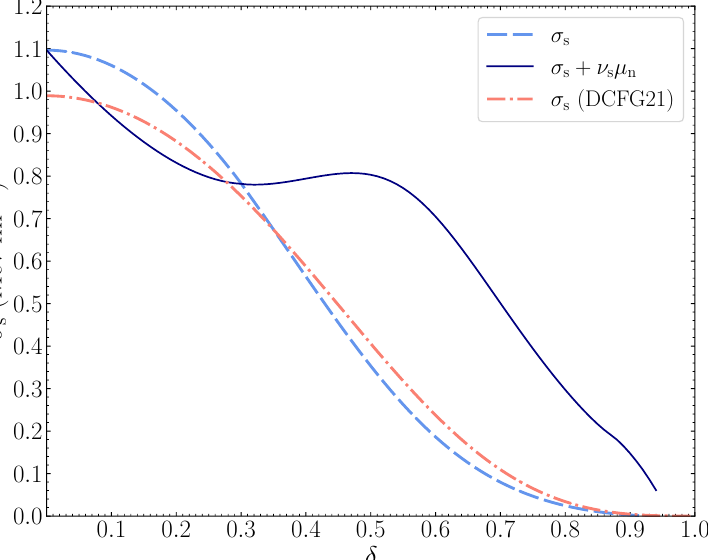
Figure 1. Surface tension of nuclear matter σ s versus neutron excess δ . The blue dashed line describes σ s , and the navy solid line represents surface energy per unit area, calculated thermodynamically consistently, i.e., taking into account the neutron skin. σ s from [40] is added for comparison (red dash–dot